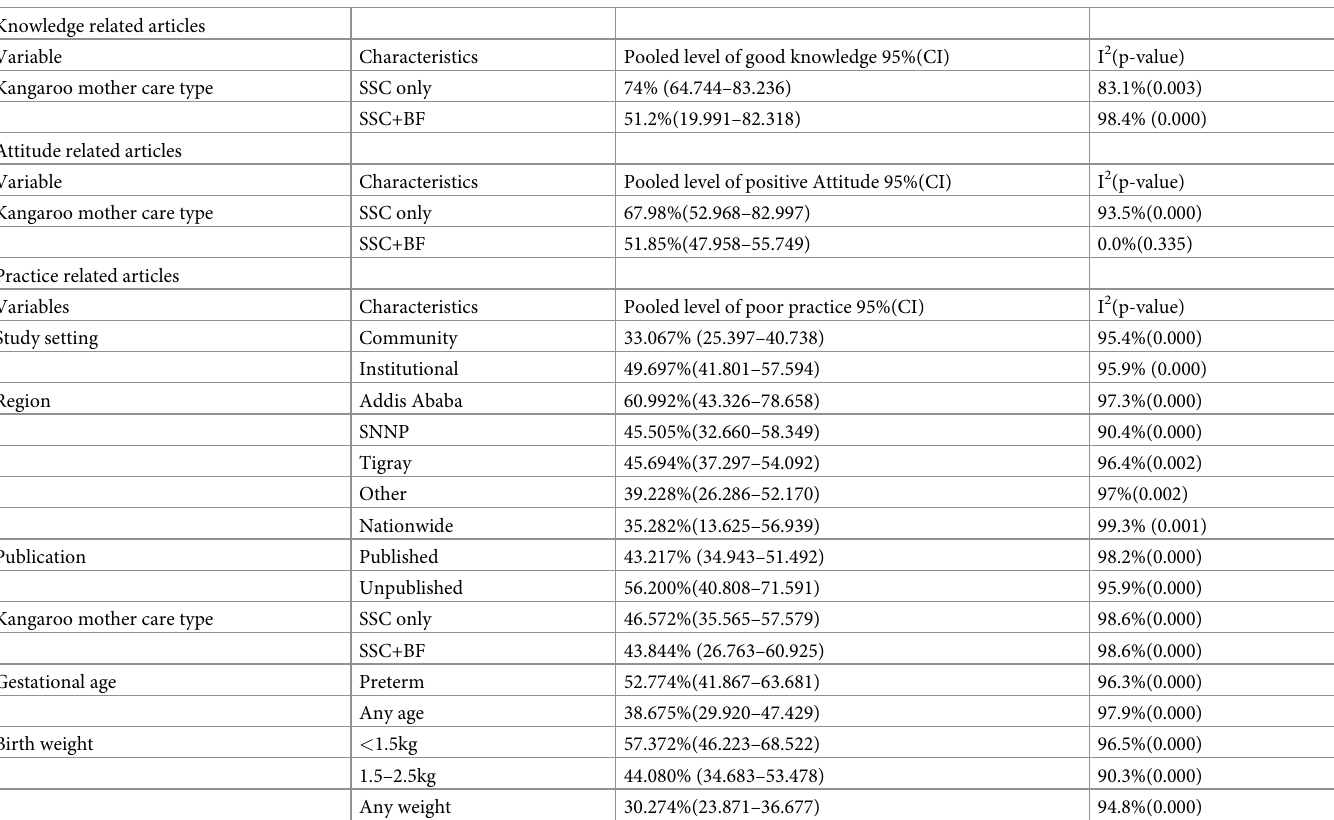
Table 3. The overall estimated level of good knowledge, positive attitude, and poor practice towards kangaroo mother care in Ethiopia, 95%CI and heterogeneity estimate with a p-value for sub-group